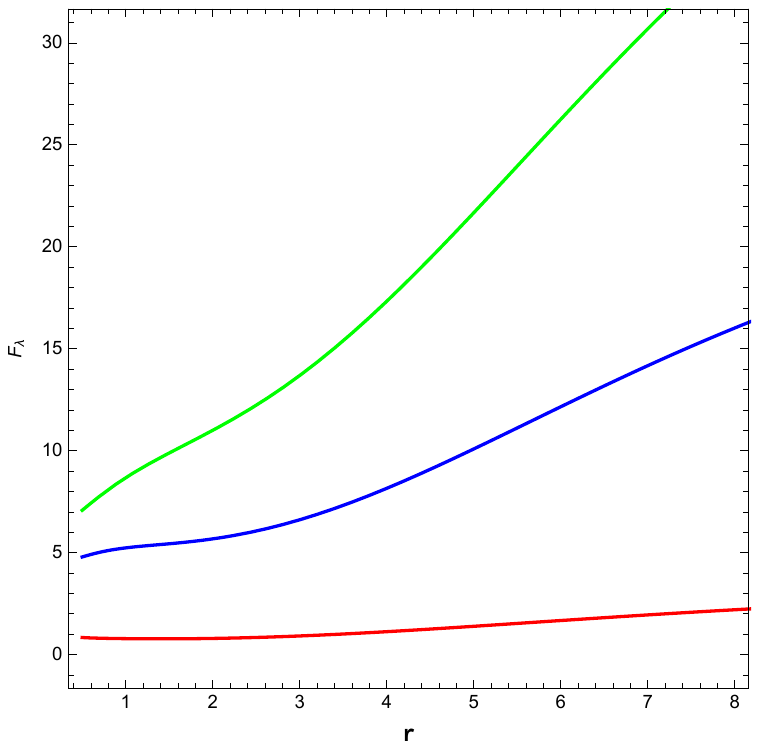
Figure 11. Solution of F ( R ( r )) for R adopted as an exponential function of radius. The evolution of partial derivative of f ( R ) is presented by comparing Equation (7) and Equation (33). We have fixed the values of η 2 , η 3 , a 0 , a 1 , a 2 , K , and C 1 . The red, green, and blue lines correspond to small perturbations of λ 0 , Ψ 0 , and η 1 ,